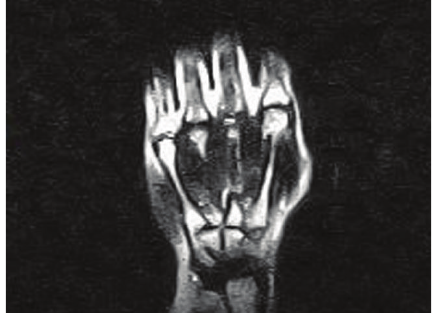
Figure 3: MR image of the volunteer without RFID tag attached to the wrist (Imaging Sequence: T 1 —Spin echo Coronal).